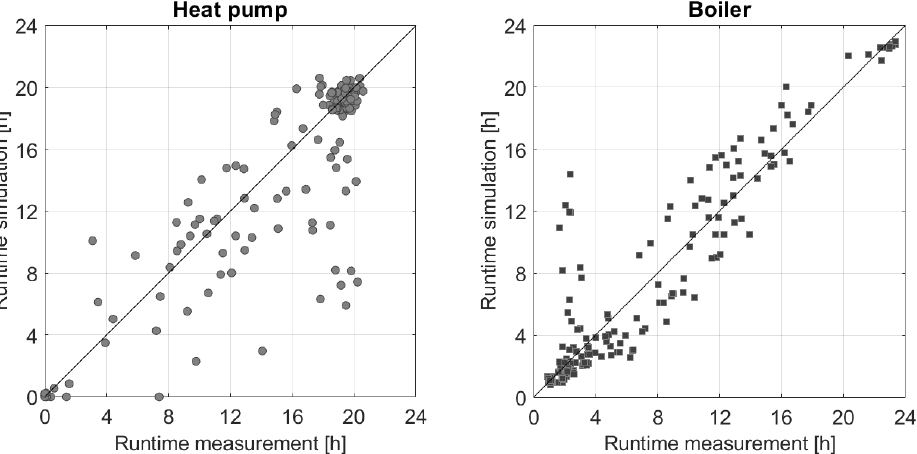
Figure 20. Daily runtime of the heat pump ( left ) and the boiler ( right ) in simulation and